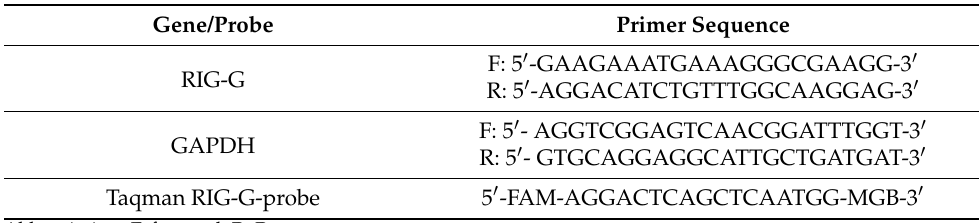
Table 1. List of primers and TaqMan-MGB probe used for reverse transcriptionquantitative poly- merase chain reaction analysis. Gene/Probe Primer Sequence